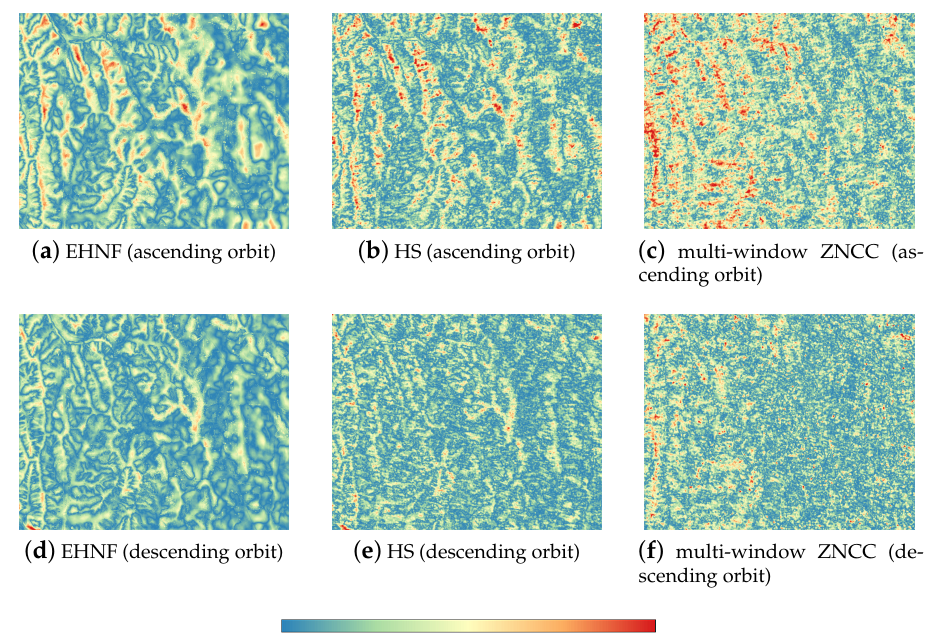
Figure 8. The root square error of mountainous DSM generated by the ( a ) EHNF algorithm; ( b ) HS flow algorithm; ( c ) multi-window ZNCC algorithm of ascending orbit stereo images, and ( d ) EHNF algorithm; ( e ) HS flow algorithm; ( f ) multi-window ZNCC algorithm of descending orbit stereo